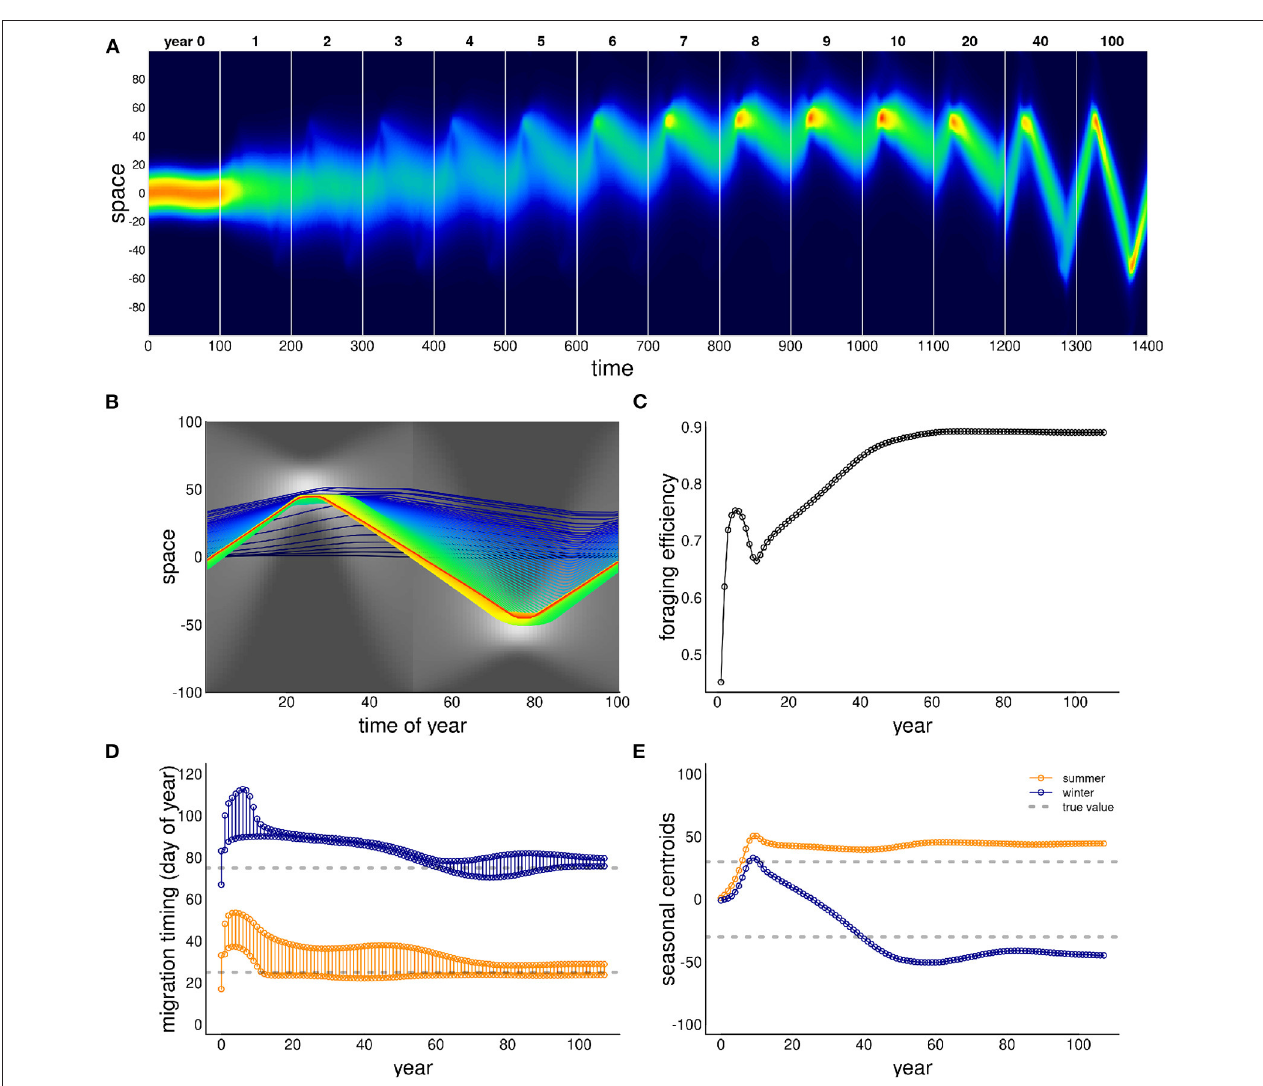
FIGURE 5 | Example of model learning to migrate. The resource is a “weakly drifting” resource and the initial (year 0) condition is non-migratory. The simulation was run for 100 years, and a sampling of those years (labeled) are presented in (A) : all years from 0 to 10, followed by 20, 40 and 100. Otherwise, panels are as in Figure 2 . Additional parameter values were ε